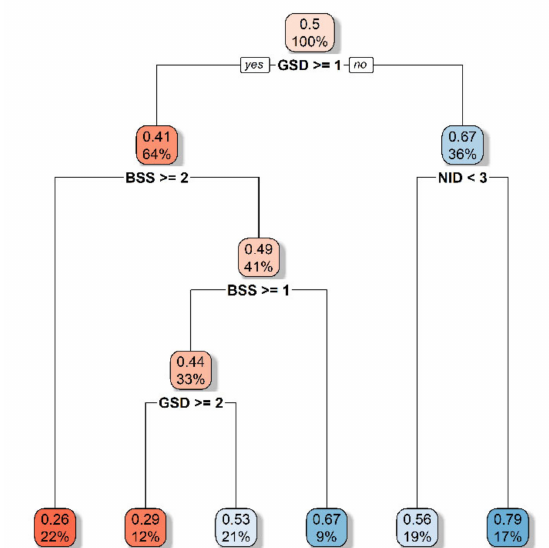
Figure 3. Hierarchy of image attributes affecting identification accuracy across all data. Each node shows the predicted proportion of correct selections (PCS_img) and percentage of observations in that dataset. Colour intensity is proportional to the predicted value. Other model trees, for the high-confidence selections and the reviewers’ mean level of confidence, are available in Supplementary S2.